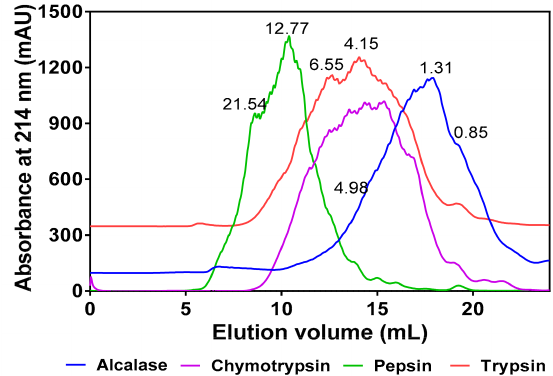
Figure 1. Comparative gel-permeation chromatograms of the four protein hydrolysates after passage through a Superdex Peptide12 10 / 300 GL column. Inserted values indicate estimated molecular weights (kDa).